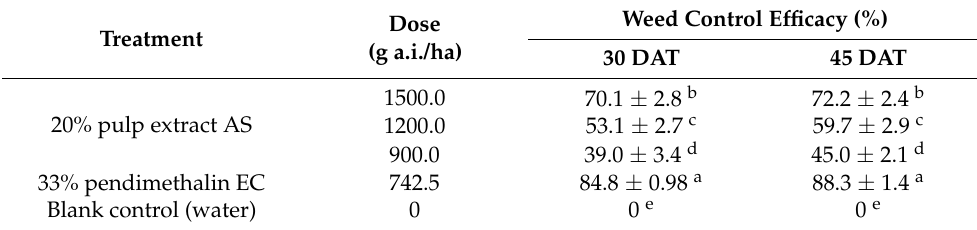
Table 4. Field efficacy of 20% pulp extract AS and pendimethalin EC against weeds in carrot.